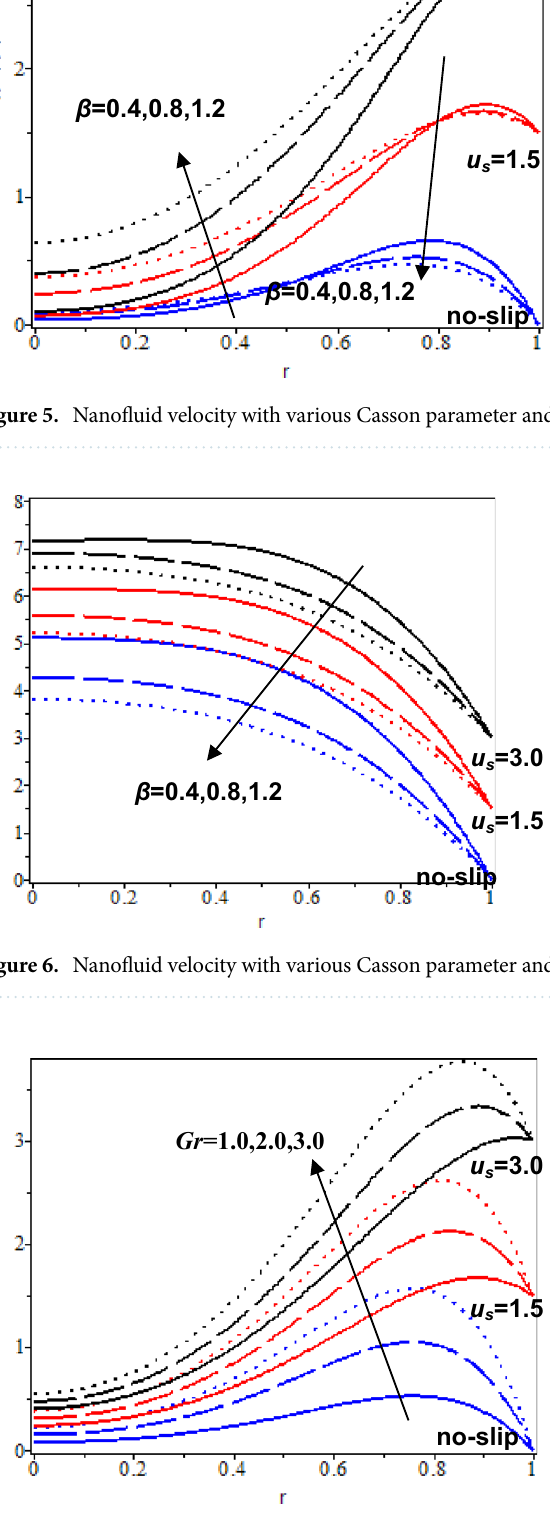
Figure 7. Nanofluid velocity with various Grashof number and slip velocity at t =